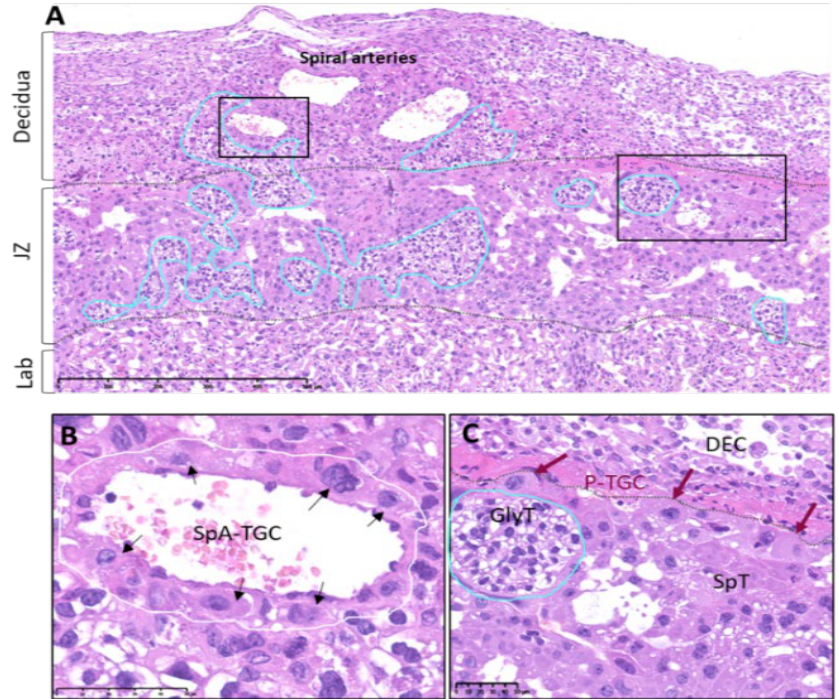
Figure 4. Histological images of mature murine placenta (E14.5) showing interstitial and endovascular remodeling pathways. ( A ) The central cross section shows the three major placental layers. Each is delineated by dotted lines. In addition, the group of GlyT cells migrates from the JZ (turquoise lines). The invading GlyTs remodel the uterine interstitium and reside in the perivascular spaces of the central canals. ( B ) A higher-magnification image shows the distal segments of the remodeled spiral arteries, which are lined by SpA-TGCs. ( C ) Higher magnification of the JZ highlights the presence of GlyTs, mixed with SpTs. Moreover, the P-TGCs are giant cells with enlarged hyperchromatic nuclei and abundant eosinophilic cytoplasm. They are in direct contact with the maternal decidua and anchor fetal-derived structures to the uterus.